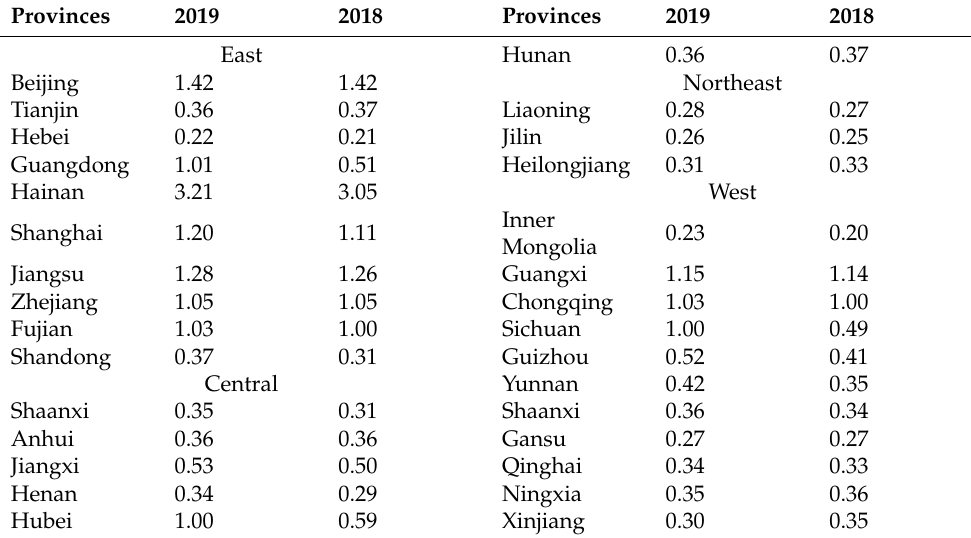
Table 4. The CEECI from 2018 to